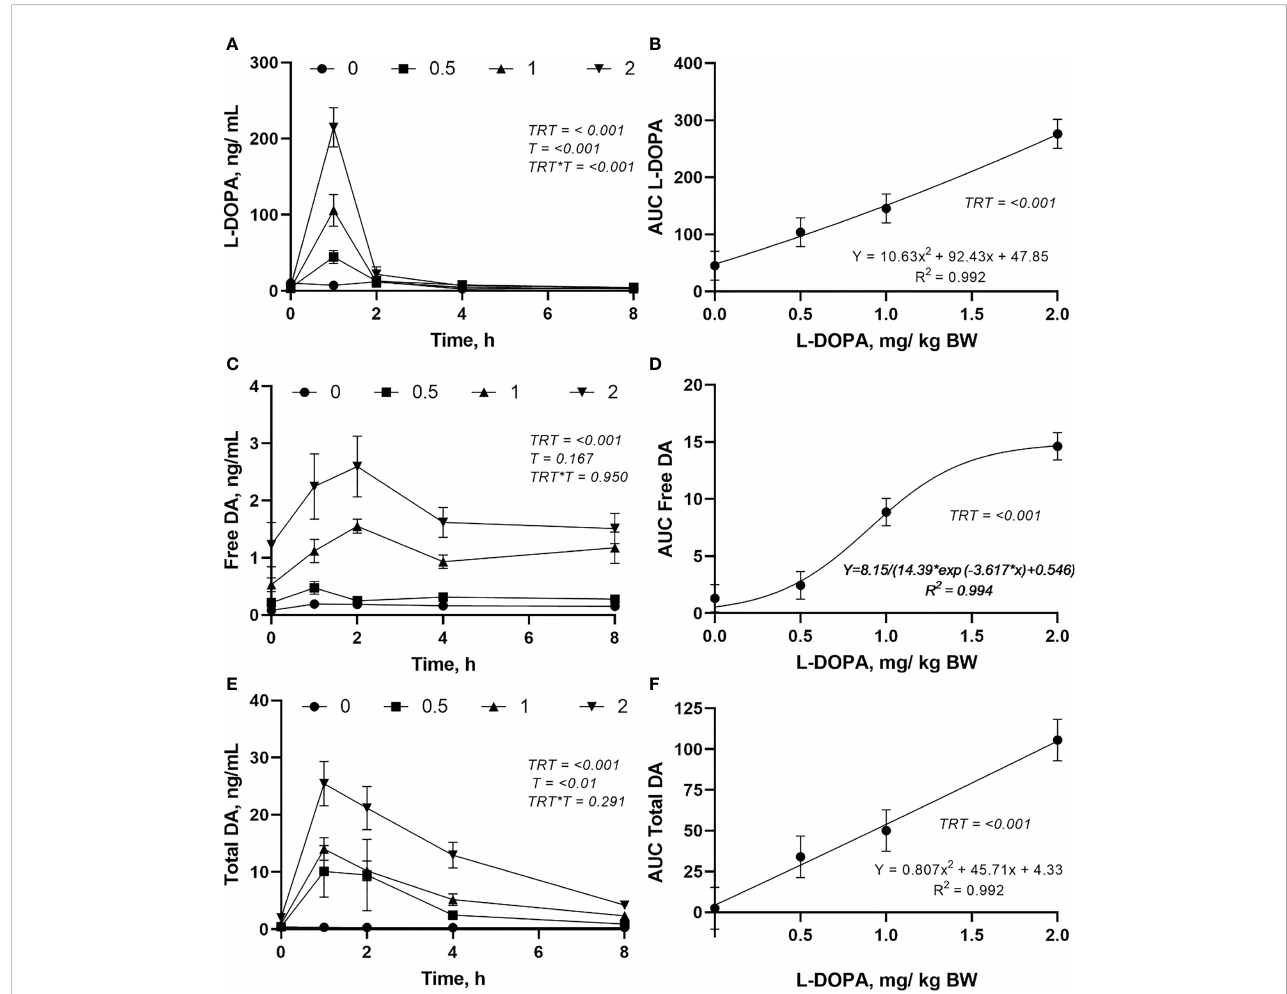
FIGURE 2 Changes in plasma L-DOPA overtime (A) , area under curve (AUC) of L-DOPA (B) , free dopamine (DA) over time (C) , AUC of DA (D) , total DA over time (E) and AUC of total DA (F) following intra-abomasal infusion of L-DOPA at 0, 0.5, 1 and 2 mg/kg BW. TRT is the effect of treatment, T is the time effect and TRT*T is the interaction. Each value is expressed as the mean ± standard error (n =